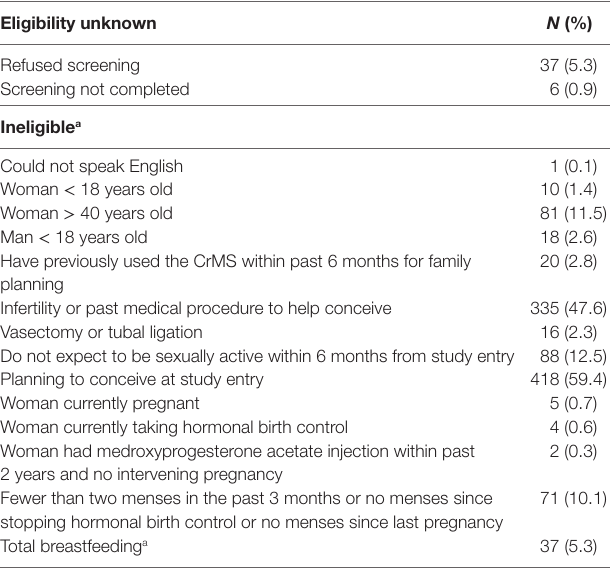
TaBle 1 | Reasons and frequencies for exclusion from the CEIBA study ( n =